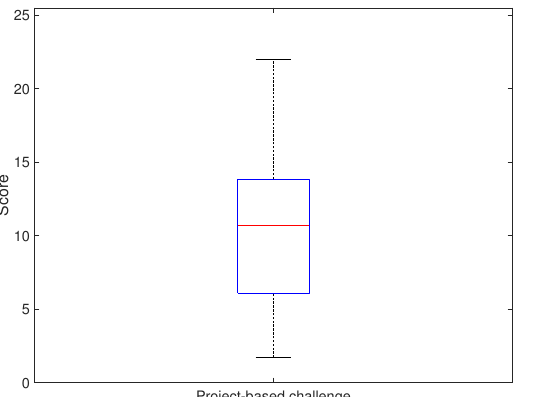
Figure 15. Evaluation results: final project (implementing imaginary system) scores (achieve- ment